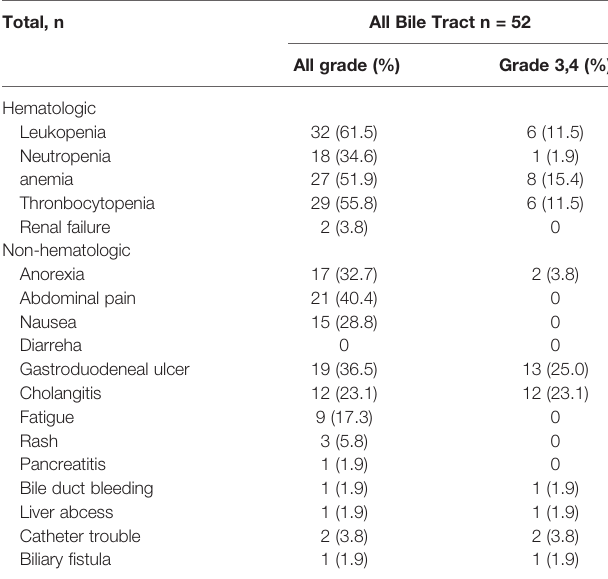
TABLE 4 | The summary of adverse